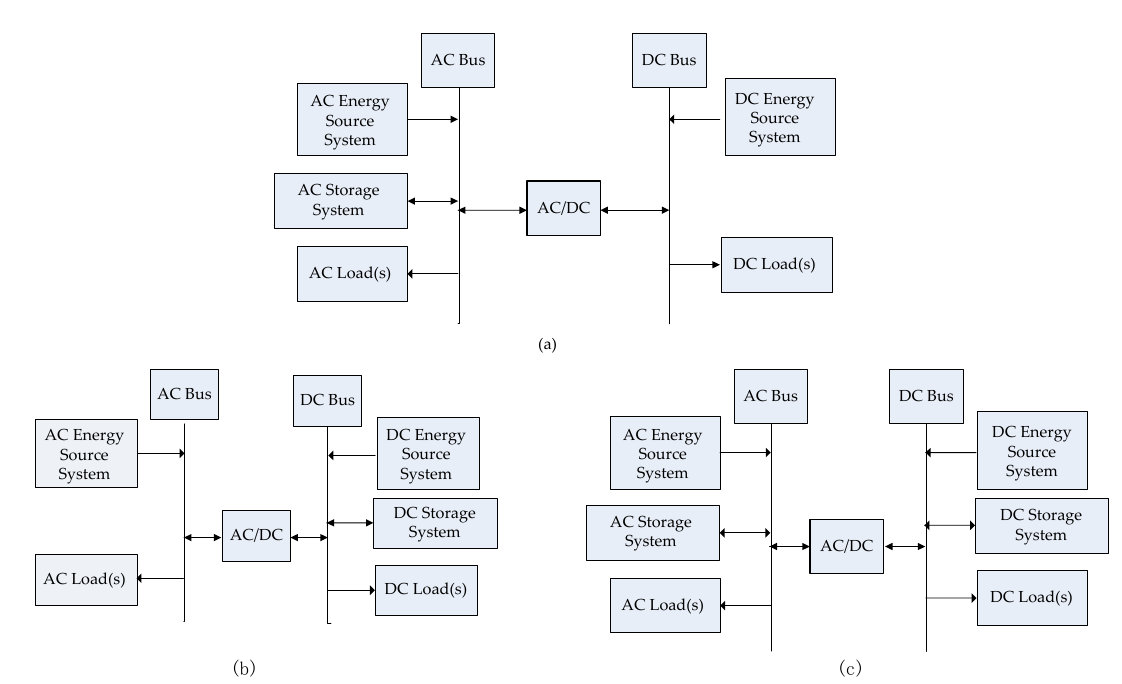
Figure 2. Classification of the configurations of the isolated hybrid AC/DC microgrid (IHMG) system: ( a ) Grid-forming units are in the AC subgrid, ( b ) grid-forming units are in the DC subgrid, and ( c ) grid-forming units are in both AC and DC subgrids.